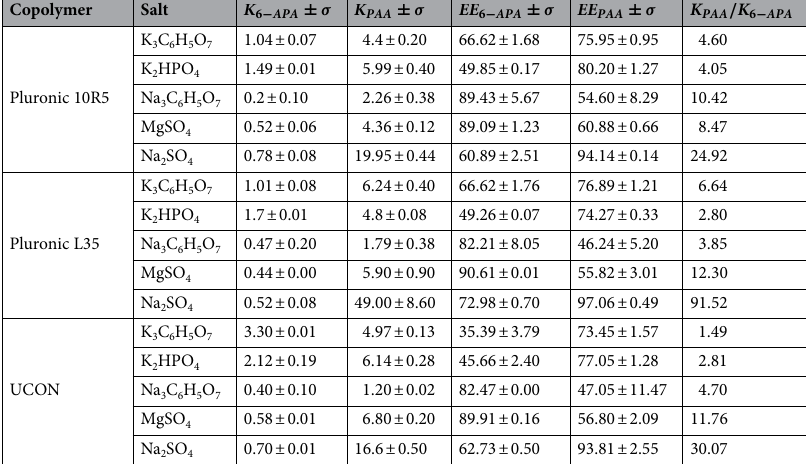
Table 2. Partition coefficient (K), extraction efficiency (EE%) and selectivity (Sel.) of 6-APA and PAA in systems based in copolymers + salts +